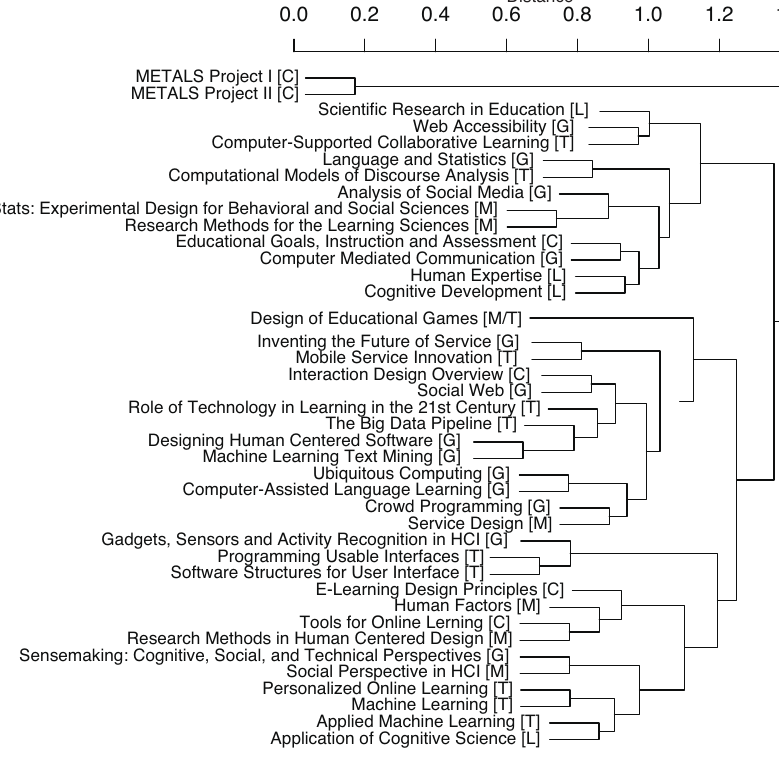
Figure 4. A dedrogram of subjects which are described as syllabi at CMU METALS ([C]:Core, [T]:Technology, [L]:Learning Sciences Theory & Industrial Design, [M]:Methods & Design, [G]:General